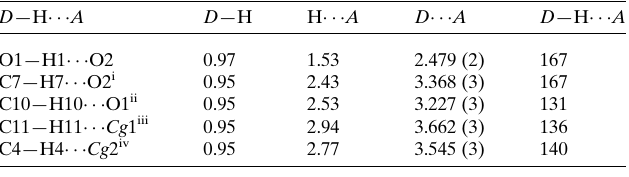
Figure 1 The title molecule with labelling scheme and 50% probability ellipsoids. The intramolecular hydrogen bond is shown by a dashed line.